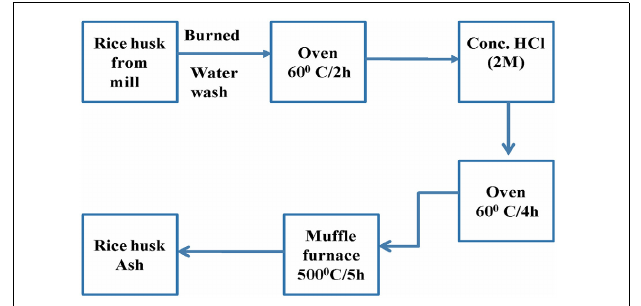
FIGURE 1 | Synthesis of rice husk ash (RHA) from rice